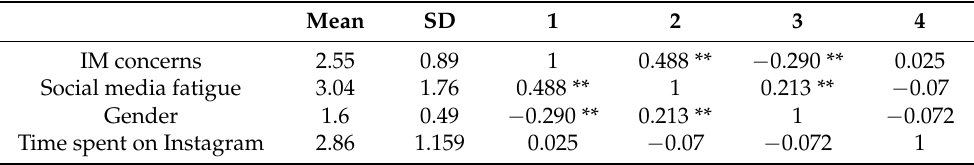
Table 1. Study 1: mean, standard deviation, and intercorrelations. Mean SD IM